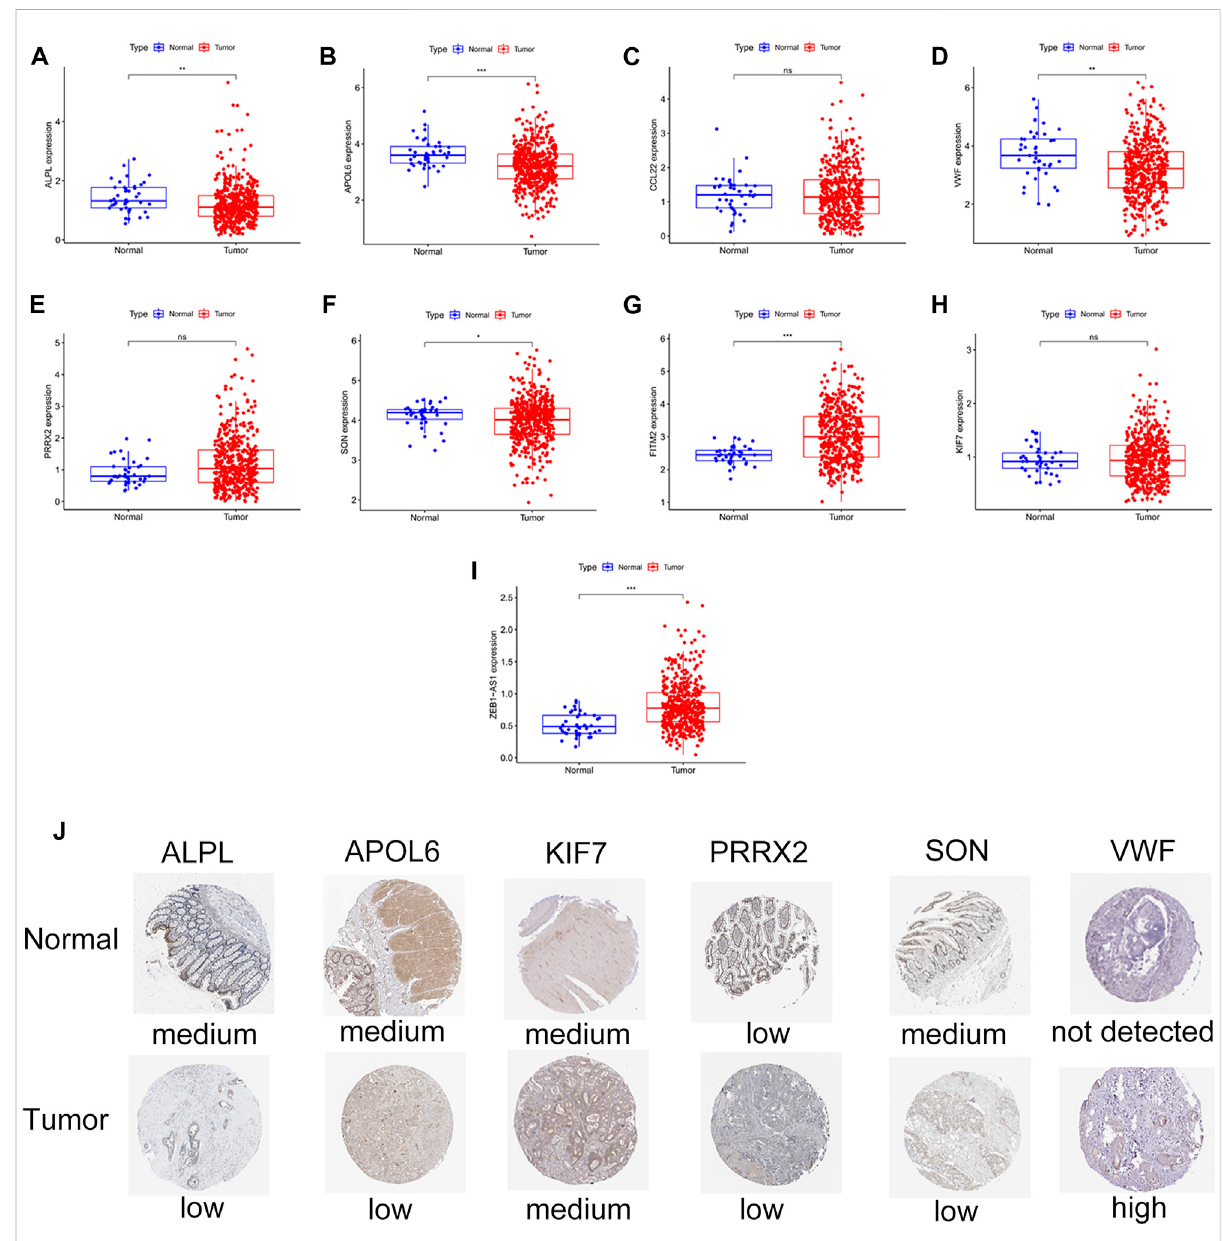
FIGURE 10 Validation ofdifferentialexpressionofFITM2,APOL6,VWF, PRRX2,CCL22,ALPL, SON,KIF7,andZEB1-AS1innormalsamplesandcoloncancer samples. (A – I) Box plots. ns represents no difference; p p < 0.05, pp p < 0.001, ppp p < 0.001. (J) Immunohistochemical maps of ALPL, APOL6, KIF7, PRRX2, SON, and VWF expression proteins in the HPA